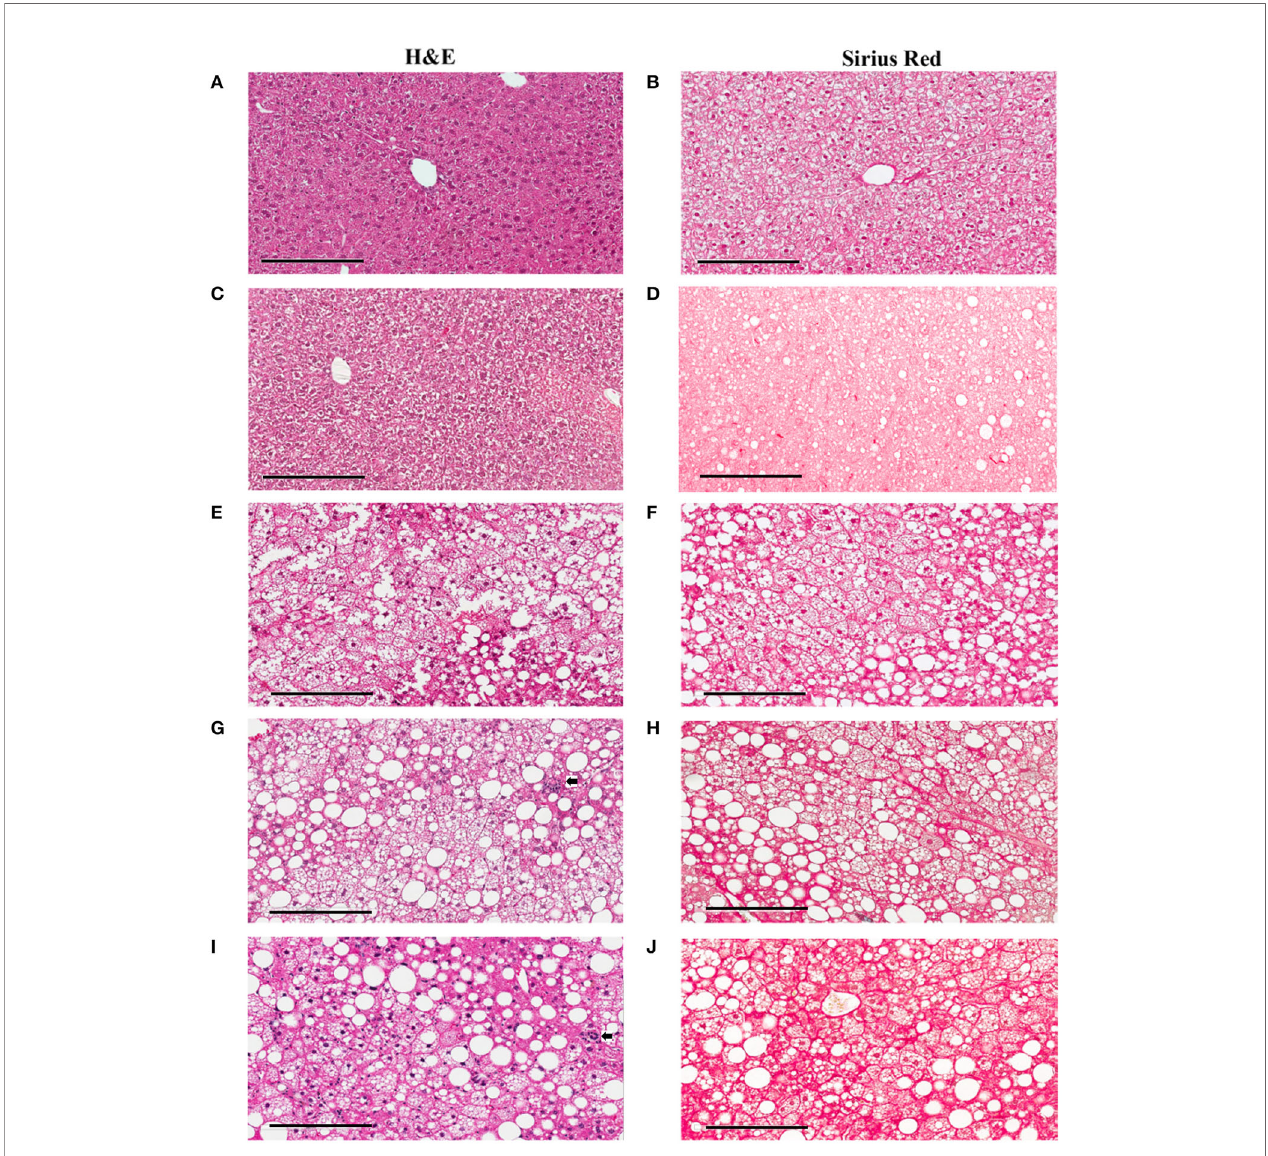
FIGURE 3 | Hepatic lesions of the NASH Mice at Different Age. The representative images were taken from the liver sections of the mice fed either rodent chow (A , B) or Western diet for 60 (C , D) , 150 (E , F) and 245 (G , H) , and 352 (I, J) days respectively. (A, C, E, G, I) are the images of the liver sections stained with H & E ; Panels (B, D, F, H, J) are the images of the liver sections stained with Sirius